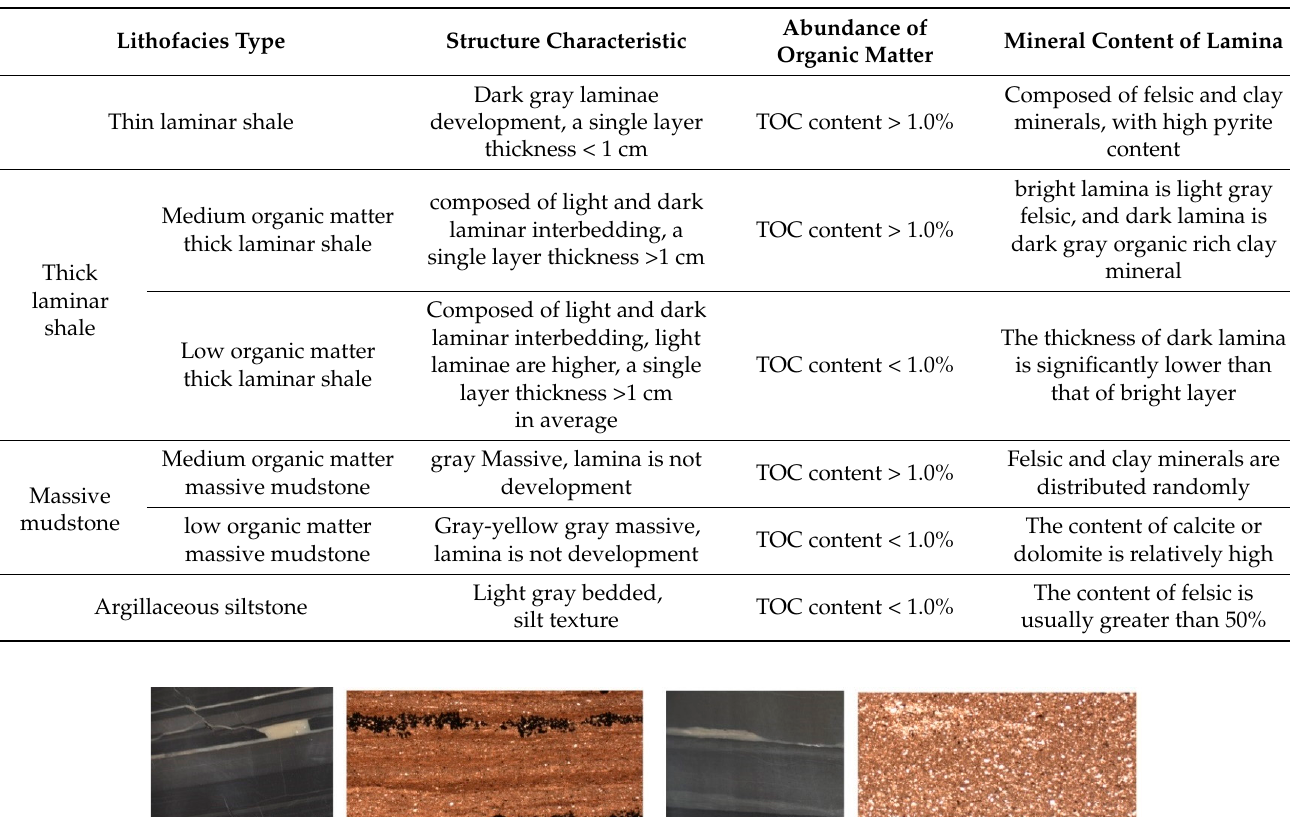
Table 1. Classification characteristics of shale lithofacies in Es3 formation.